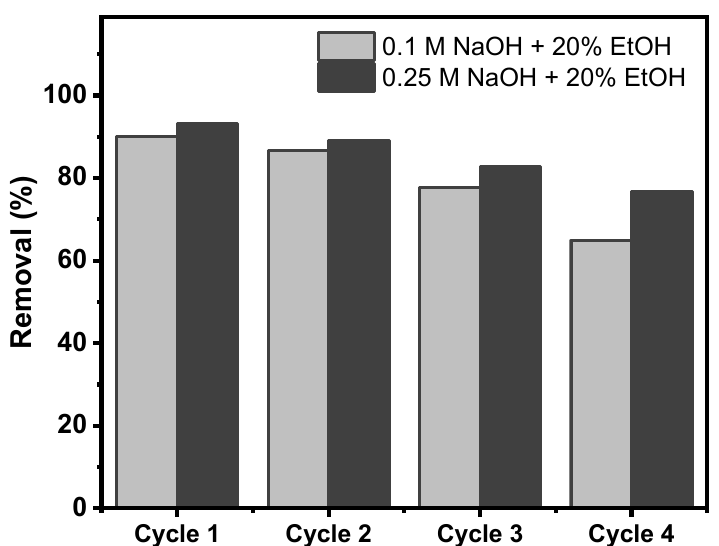
Figure 15. Effect of the eluent on the desorption and adsorption–desorption cycles.